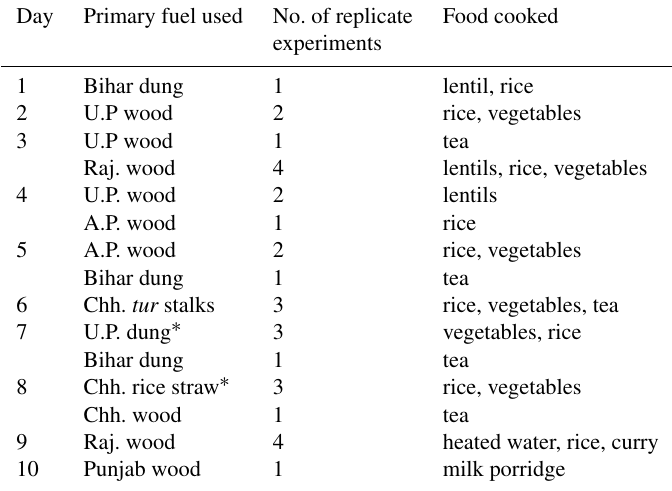
Table 2. List of cooking experiments conducted during the 10-day intensive study period. Abbreviations for Indian states: U.P.: Uttar Pradesh; Raj.: Rajasthan; A.P.: Andhra Pradesh; Chh.: Chhattisgarh. Day Primary fuel used